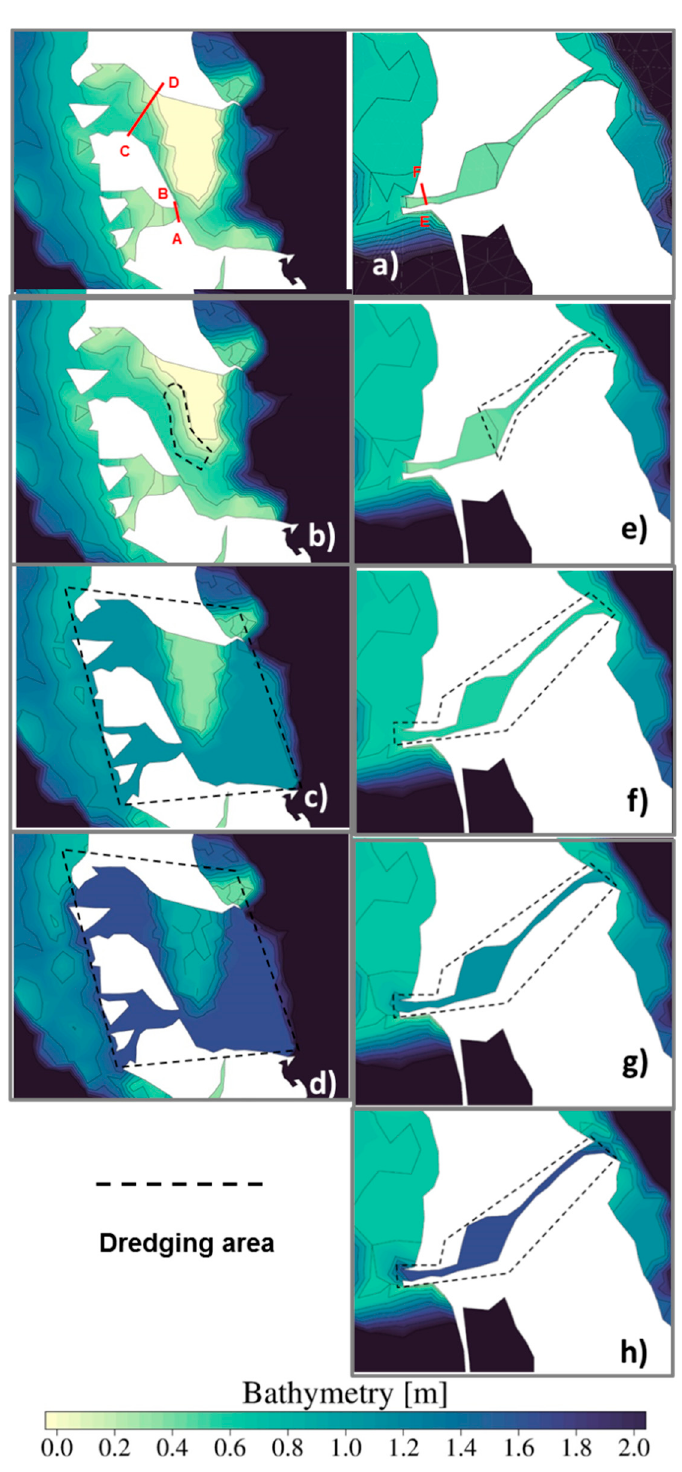
Figure 7. Bathymetry for dredging scenarios: ( a ) Undisturbed; ( b ) Maint_Enc; ( c ) Enc_1m; ( d ) Enc_1.5m; ( e ) Mar_part_0.5m; ( f ) Mar_0.5m; ( g ) Mar_1m; ( h ) Mar_1.5m.